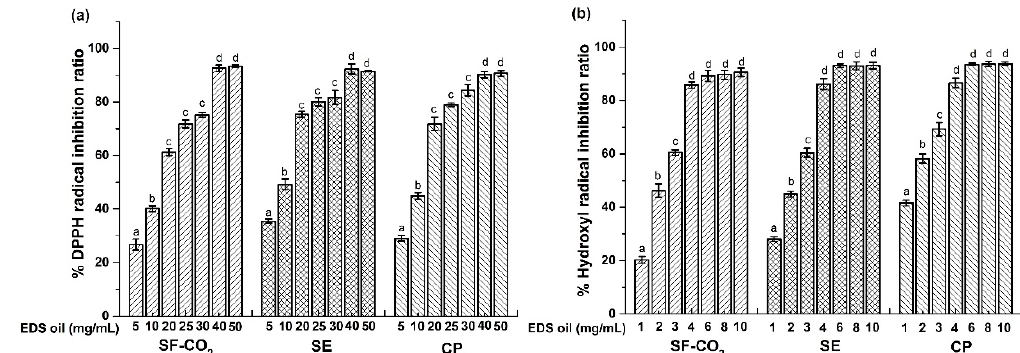
Figure 2. Free radical scavenging activities of EDS oil determined by ( a ) DPPH and ( b ) Hydroxyl assays. Data represent the mean of three independent experiment, each performed in triplicate (n = 3). Values in the bar with different letters (a, b, c, d) are significant difference at p < 0.05.